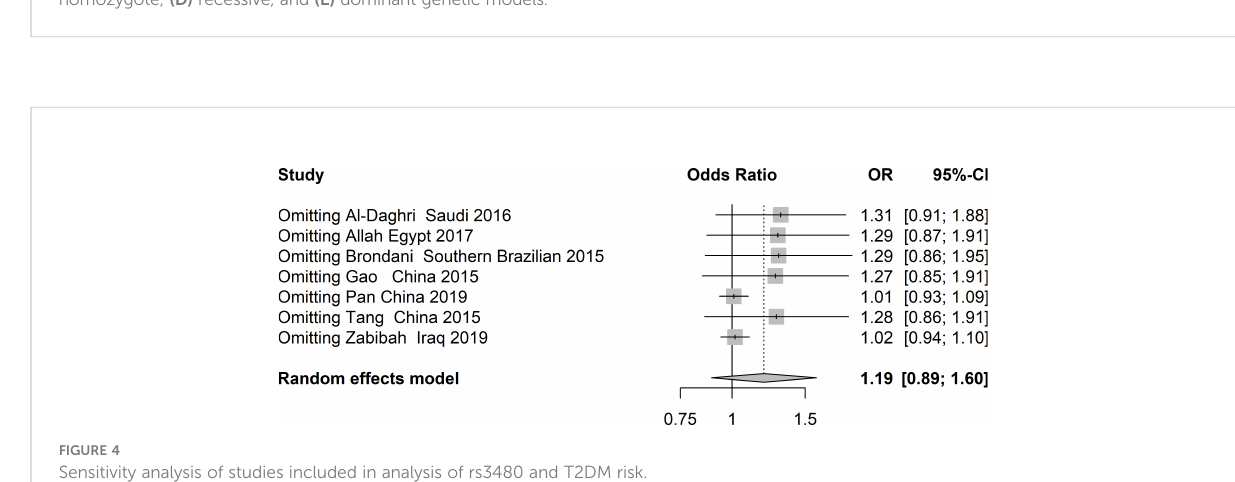
FIGURE 3 Forest plots of the polymorphism of rs3480 and the T2DM risk under fi ve genetic models in Chinese. (A) allelic, (B) heterozygote, (C) homozygote, (D) recessive, and (E) dominant genetic models.